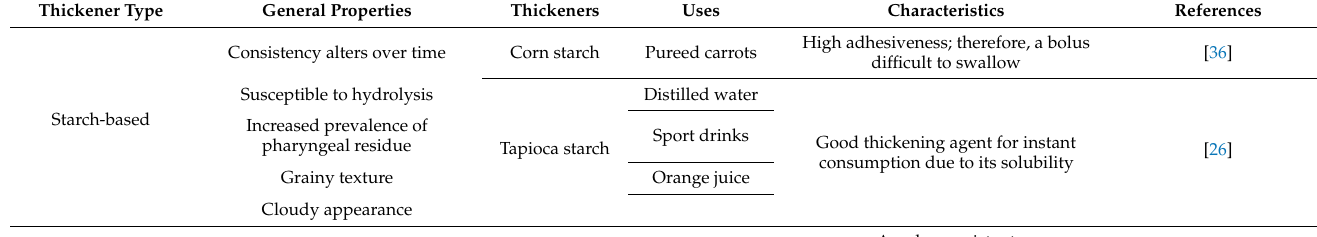
Table 2. Summary of textural and technological properties of some starch-based and gum-based thickeners used in the last few years in dysphagia